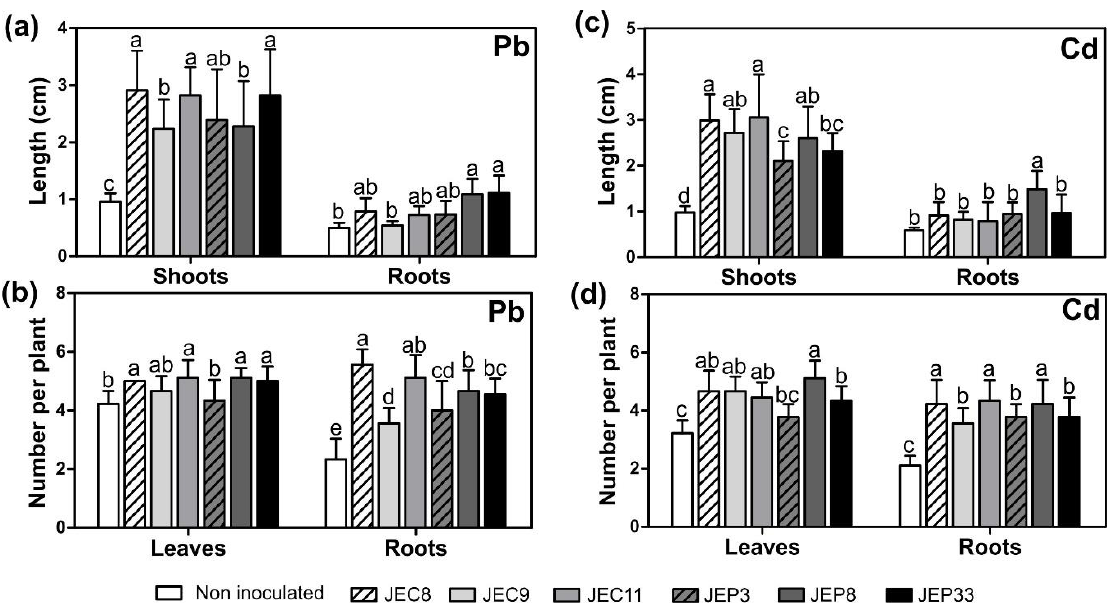
Figure 4. Effect of Pb- and Cd-tolerant isolates in T. latifolia seedlings. Pb-exposed T. latifolia seedlings ( a ) Length of root and shoots, ( b ) Number of leaves and roots per plant. Cd-exposed T. latifolia seedlings, ( c ) Length of root and shoots, ( d ) Number of leaves and roots per plant. Data represent the mean ± SD. Different letters indicate significant differences between treatments ( p < 0.05).